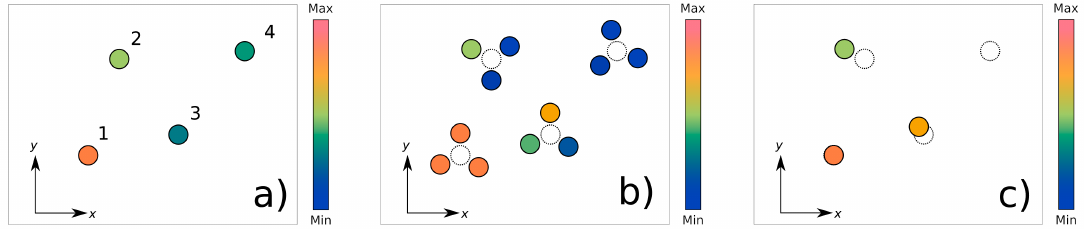
Figure 4. Graphical analysis of a test case; a dashed white circle in ( b , c ) gives the position of starting sources of ( a ). Source 1 is not changed by the inflation/deflation. Source 2 and 3 are moved. Source 4 has a very small excitation, so it is